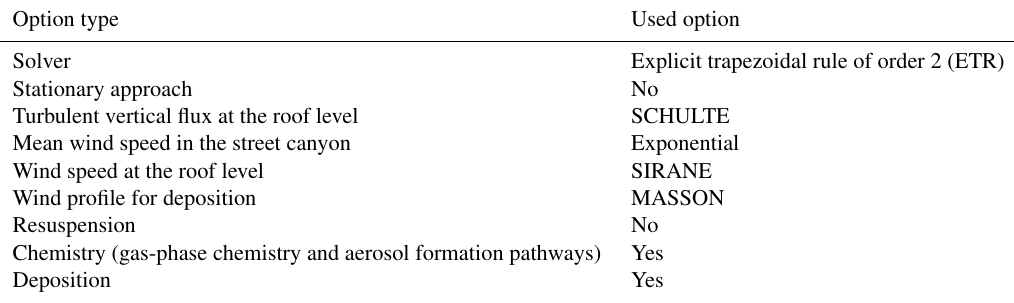
Table 2. List of options used in the reference simulation.